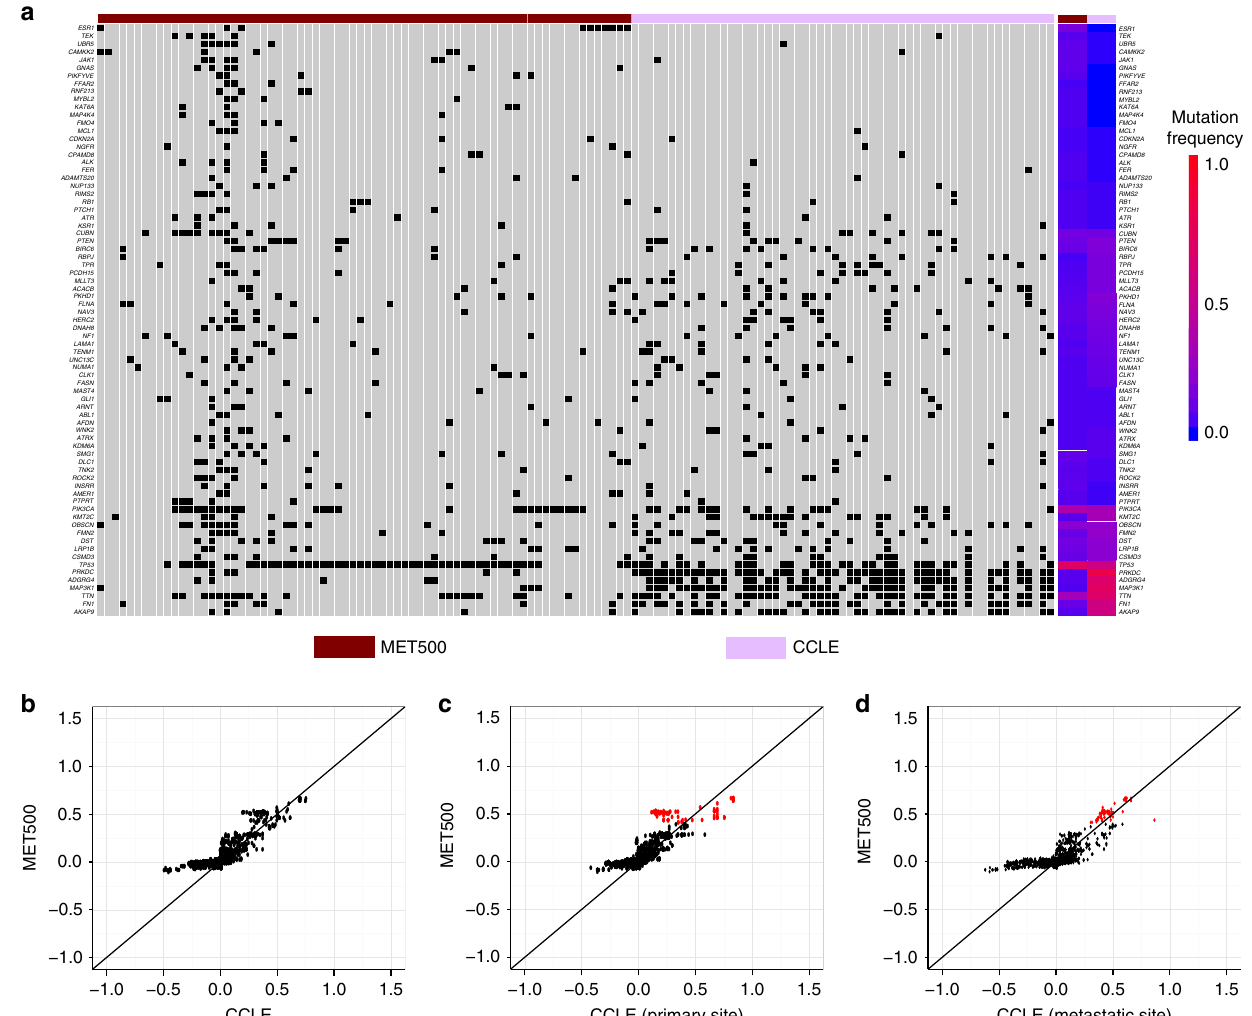
Fig. 2 Comparison of genomic pro fi les between MET500 breast cancer samples and CCLE breast cancer cell lines. a Somatic mutation pro fi le of the 75 genes across MET500 breast cancer samples and CCLE breast cancer cell lines. The top-side color bar indicates data sources (MET500 or CCLE) and the right-side color bar indicates mutation frequency. b Comparison of CNV pro fi les between MET500 breast cancer samples and CCLE breast cancer cell lines. c Comparison of CNV pro fi les between MET500 breast cancer samples and the 33 primary-site derived CCLE breast cancer cell lines. d Comparison of CNV pro fi les between MET500 breast cancer samples and the 24 metastatic-site-derived CCLE breast cancer cell lines. In panels b – d , each dot is a gene, with y -axis representing its median CNV value across MET500 breast cancer samples, and x -axis representing its median CNV value across CCLE breast cancer cell lines. In panels c and d , genes with high copy-number-gain in MET500 breast cancer samples were marked by red. Source data are provided as a Source Data fi